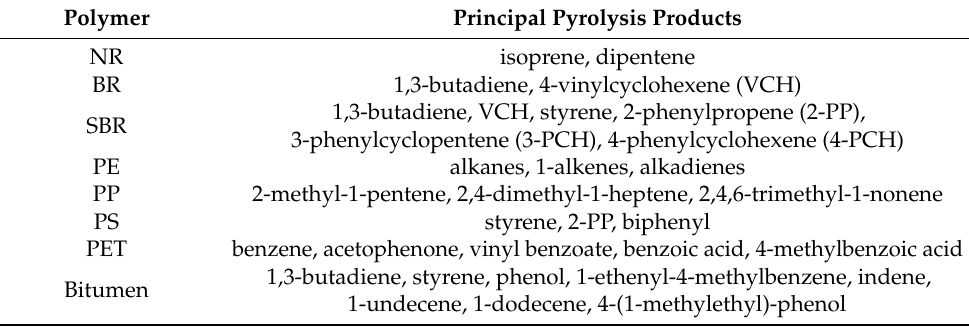
Table 3. Principal pyrolysis products of the reference organic polymeric samples.